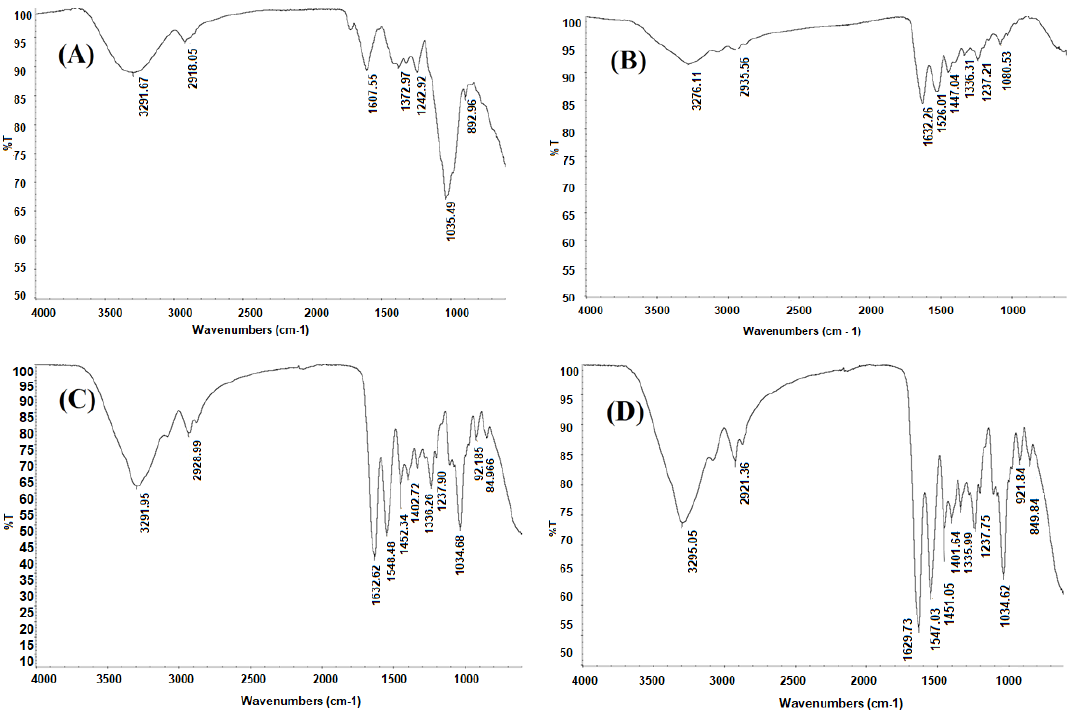
Figure 3. Fourier transform infrared (FTIR) spectra: ( A ) CM, ( B ) gelatin, ( C ) control capsule and ( D ) composite capsule, scanned at wavenumbers 4000–400 cm − 1 .